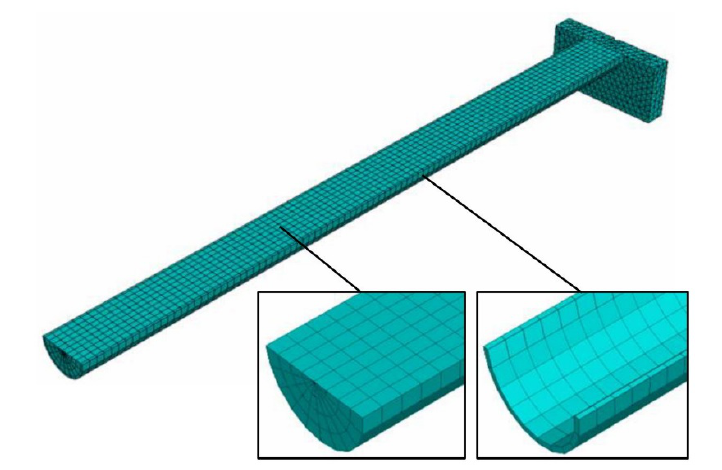
Figure 5. FE model of CFCC with loading plate, concrete core and steel tube in detail (Adapted from [17]).